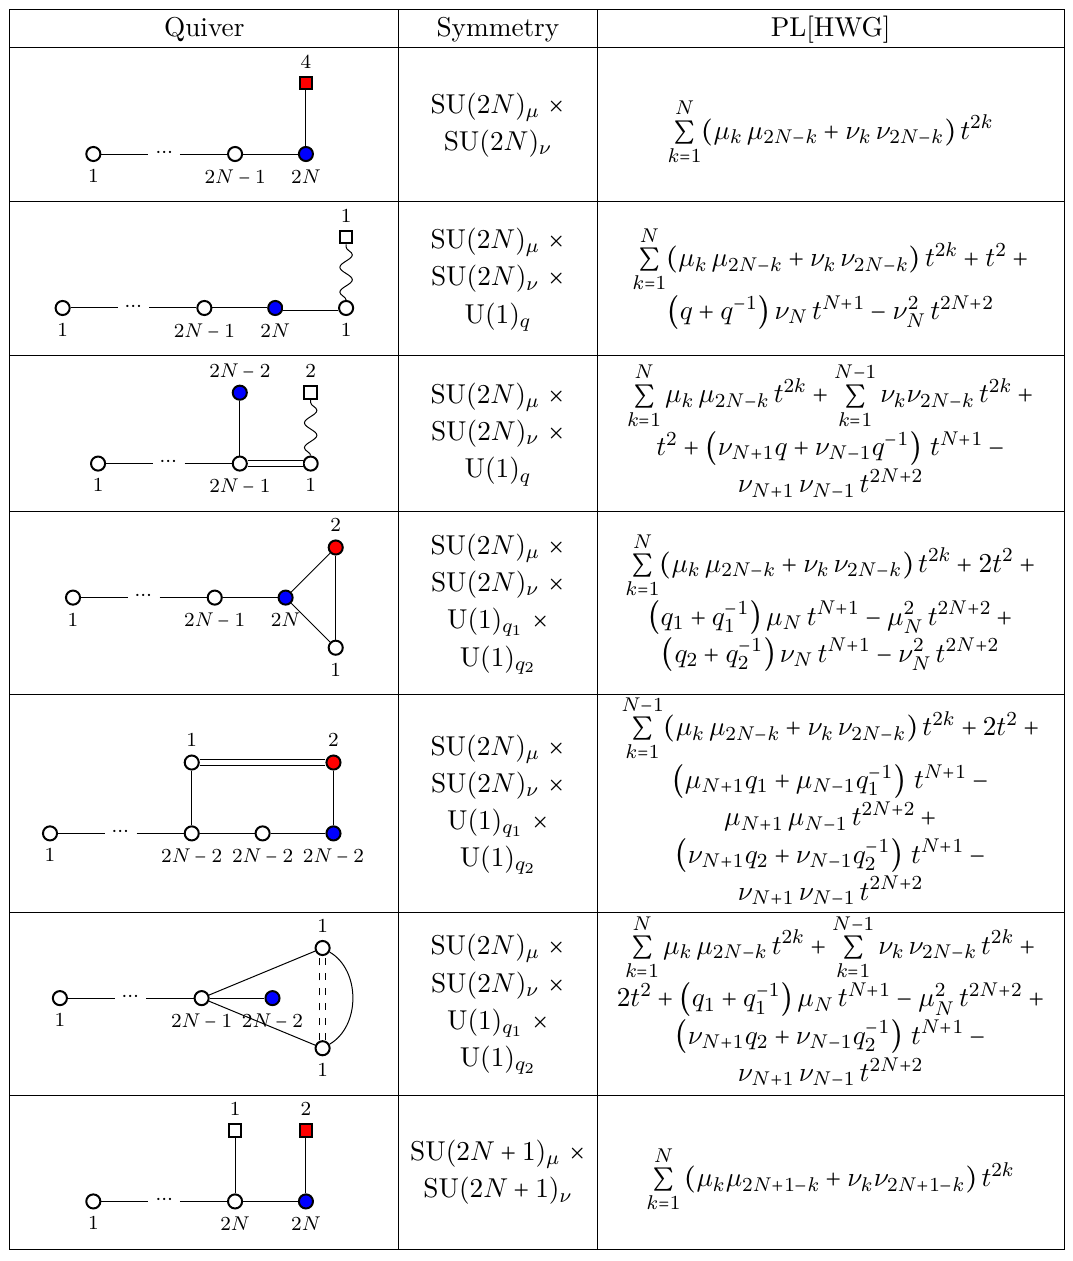
Table 1. Summary of the orthosymplectic quivers, their Coulomb branch symmetry and the associated HWG. The corresponding fugacities are denoted by subscripts in the symmetry groups. Note that for N = 1 , there is an enhancement in the symmetry as detailed in the later sections. The notations for the quivers are defined in the beginning of section